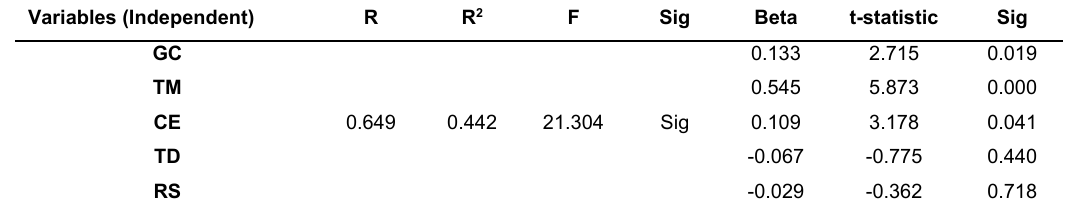
Table 8. Corporate governance and affective